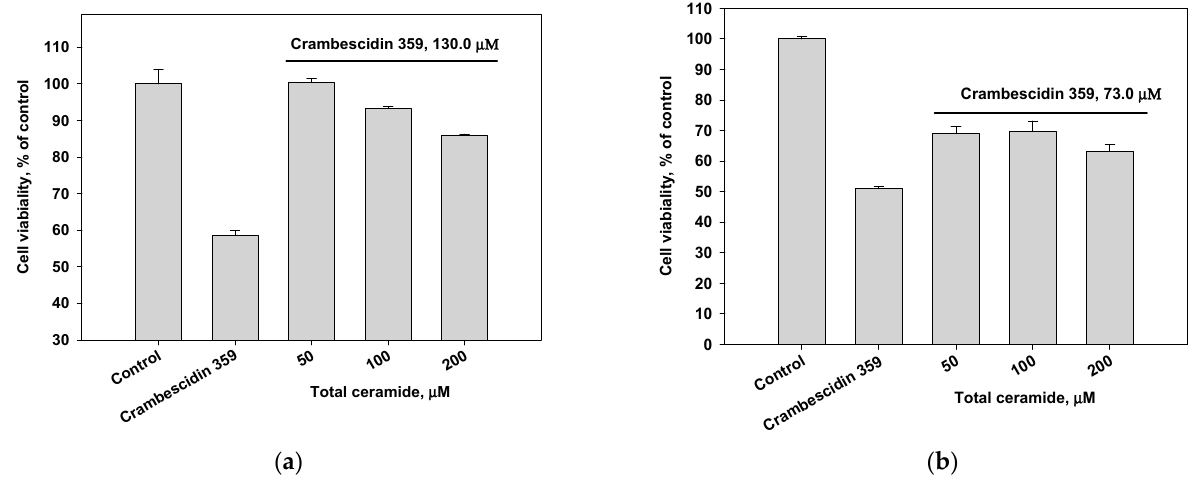
Figure 4. Cytotoxic e ff ects of crambescidin 359 at the concentration of IC 50 on ( a ) MDA-MB-231 and ( b ) HL-60 cell lines after 24 h pre-incubation of the cells with total ceramide in various concentrations. Combinations of cisplatin and total ceramide were slightly more cytotoxic for MDA- MB-231 cells (Figure 5a) than only cisplatin. However, these combinations insignificantly increased the survival of HL-60 cells (Figure 5b). After 24 h pre-incubation of MDA-MB-231 and HL-60 cells with total ceramide (especially, at a concentration of 50 µ M), the cytotoxic effect of cisplatin was noticeably reduced (Figure 5c,d).